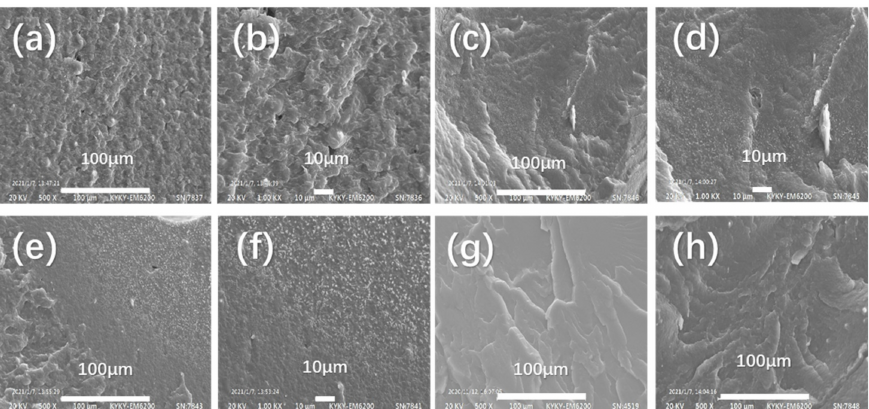
Figure 2. The SEM images of PBAT-HMNC composites: ( a , b ) PBAT-TPS composite; ( c , d ) HMNC-0.3; ( e , f ) HMNC-0.6; ( g ) PBAT; and ( h ) TPS.